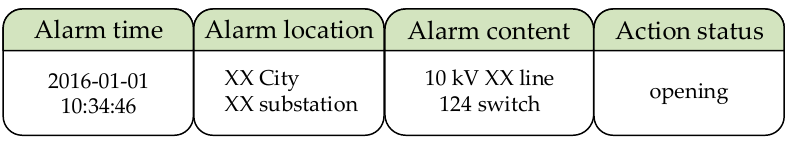
Figure 1. Example of alarm information.